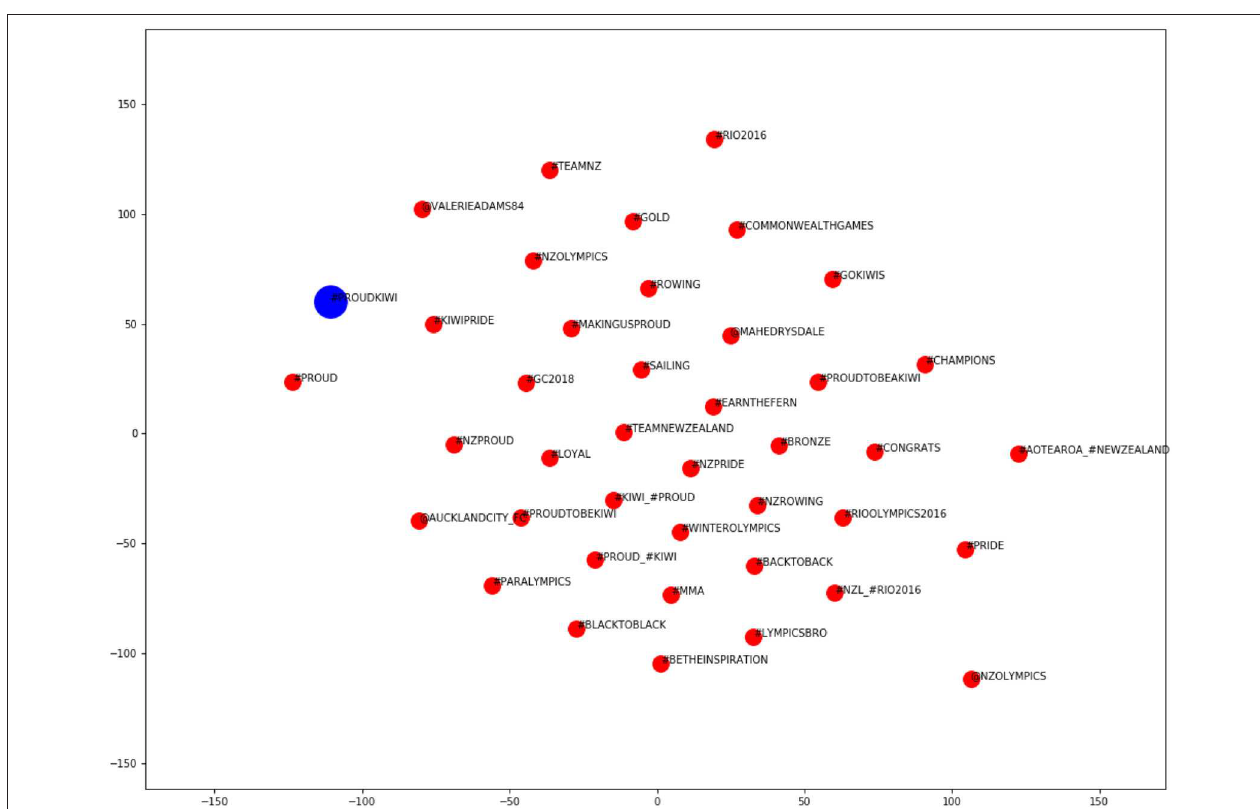
FIGURE 4 | Word embedding plot for the hashtag